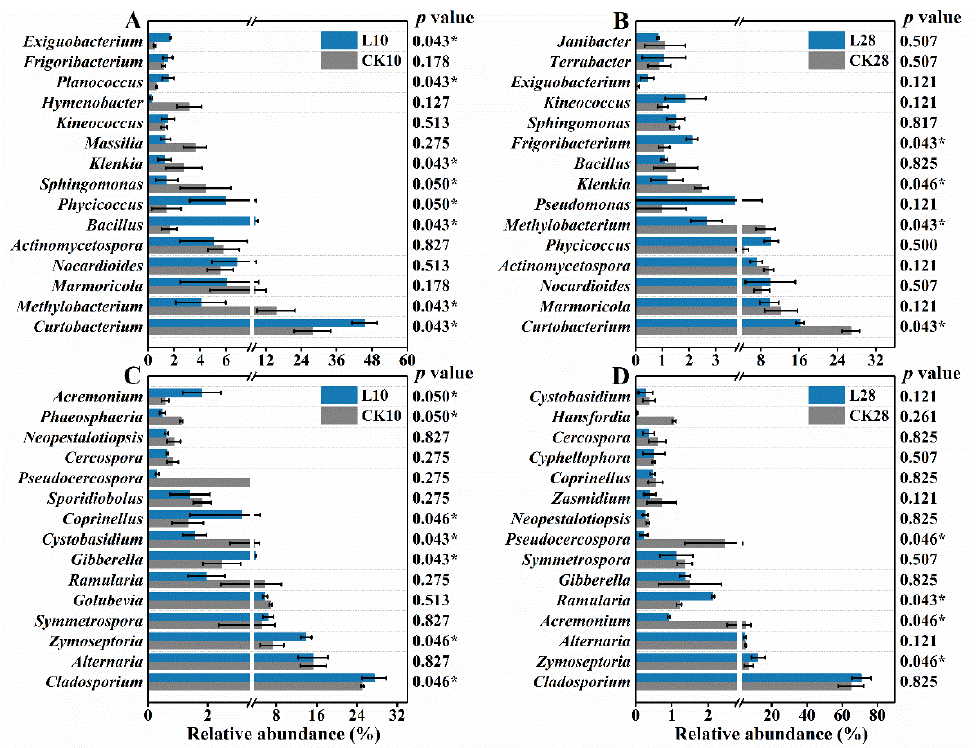
Figure 3. The microbial composition successions in the phyllosphere during the low-level ozone exposure. Bacteria compositional changes after 10 d ( A ) and 28 d ( B ) exposure and fungal compositional changes after 10 d ( C ) and 28 d exposure ( D ). Error bars represent the standard deviation of replicates ( n = 3). p values were calculated by Mann – Whitney – Wilcoxon (MWW) test (* 0.01 < p ≤ 0.05).